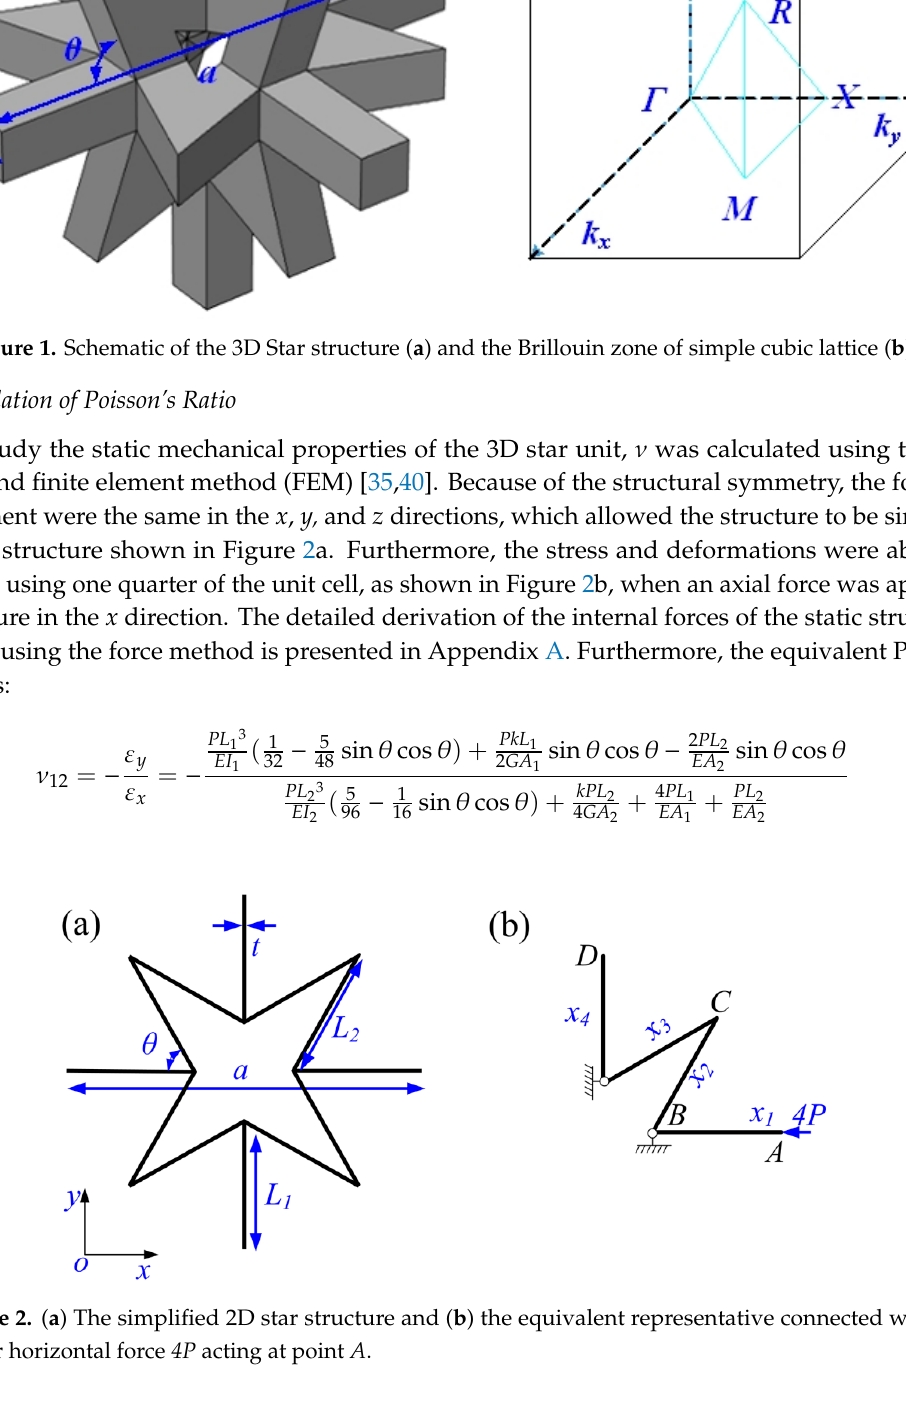
Figure 2. ( a ) The simplified 2D star structure and ( b ) the equivalent representative connected walls under horizontal force 4P acting at point A .